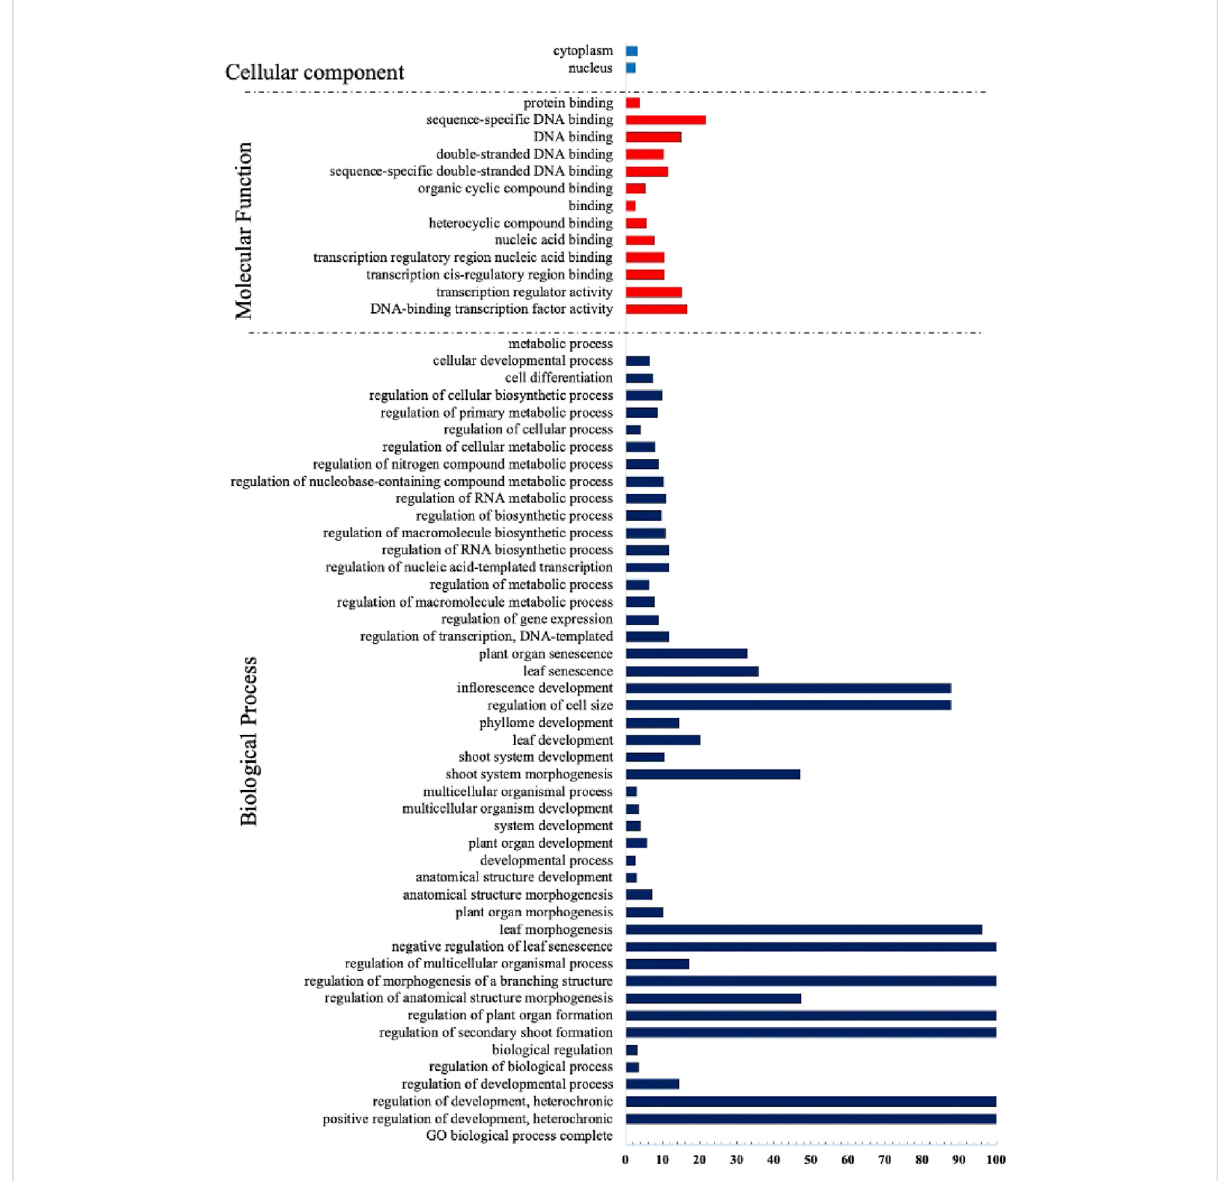
FIGURE 6 Gene Ontology Analysis of the TCP proteins in A. thaliana. GO terms were assigned using the online tool Gene Ontology Resources (http:// geneontology.org/) from A. thaliana gene IDs.